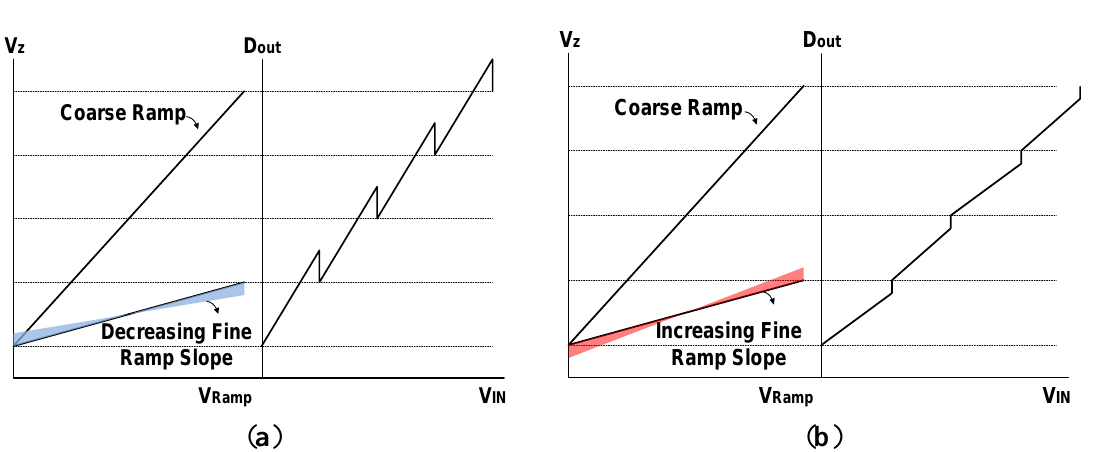
( a ) decrease of fine ramp slope; ( b ) increase of fine ramp slope.